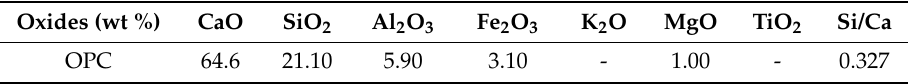
Table 2. Chemical composition expressed as oxides (wt %) of cement.